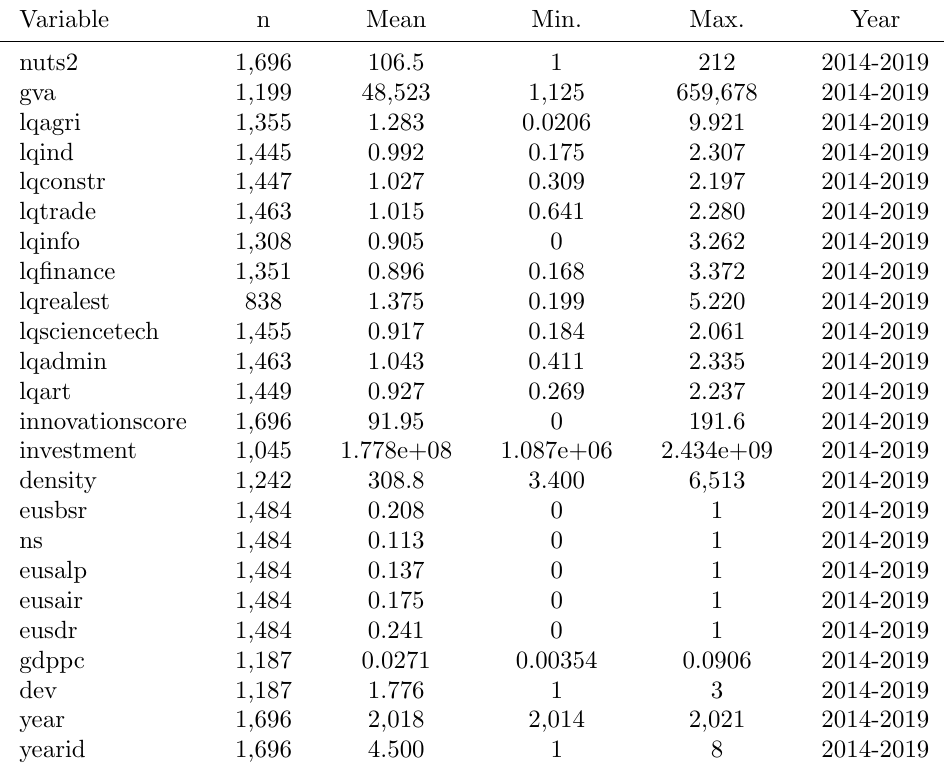
Table 2: Descriptive analysis of